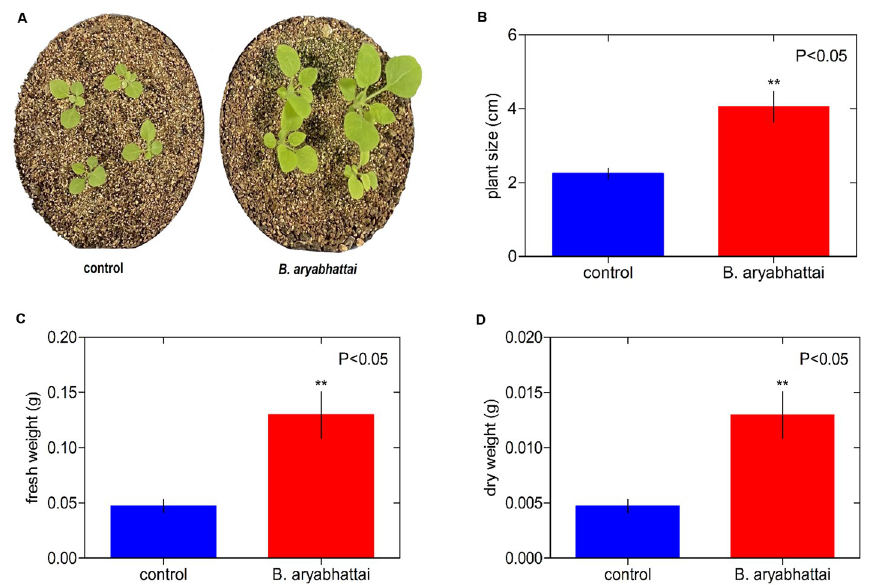
Fig 2. The endophytic bacterium B . aryabhattai enhances Nicotiana tabacum plant growth. A) Phenotype (at 20 days post inoculation) of mock-treated N . tabacum plants (control) and those treated with B . aryabhattai . Plant size (B) , fresh (C) , and dry weight (D) of mock-treated and B . aryabhattai -treated N . tabacum plants. The mean results with standard errors from two separate experiments (n = 15) are represented by each bar.